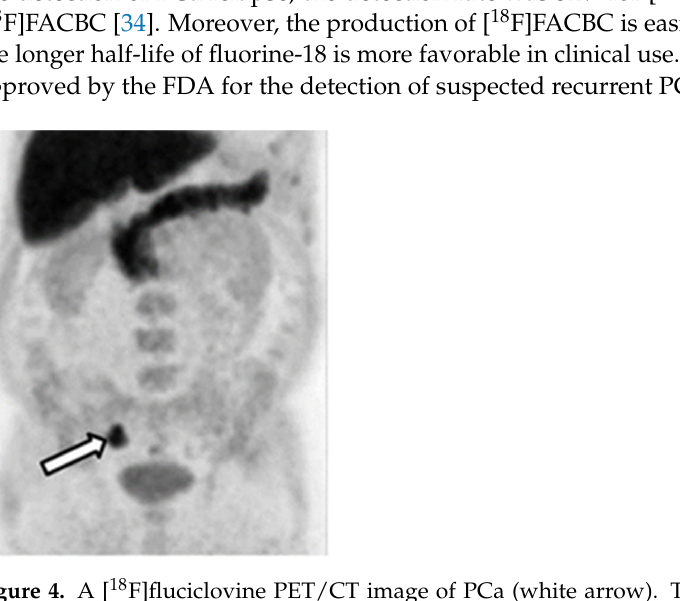
Table 2. Diagnostic performance of [ 18 F]FACBC in the BCR of PCa.